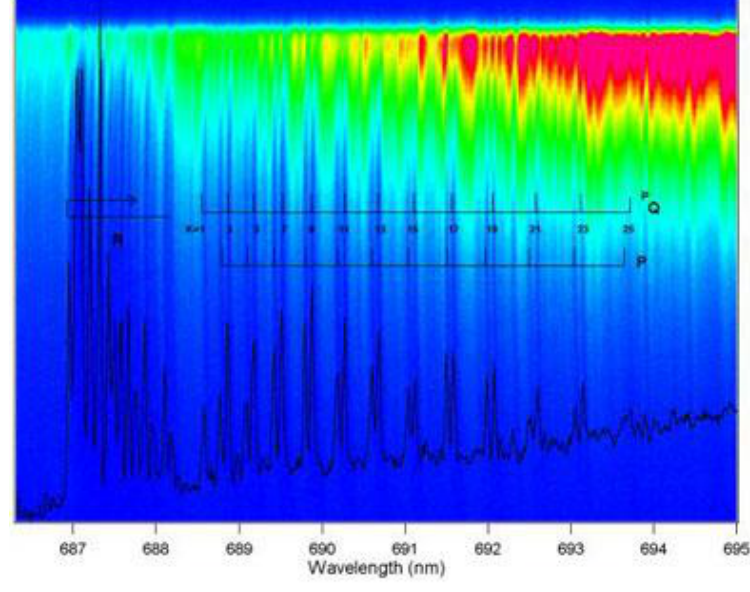
Figure 2. The combined time-domain and broadband ICOS spectra of the weak oxygen b-x (1,0) band is clearly seen. The broadband-ICOS spectrum can be recovered by doing a linear integration along a line at any constant height (the time axis in the Spectral Photography image) (reproduced with permission from the Optical Society of America [37]).